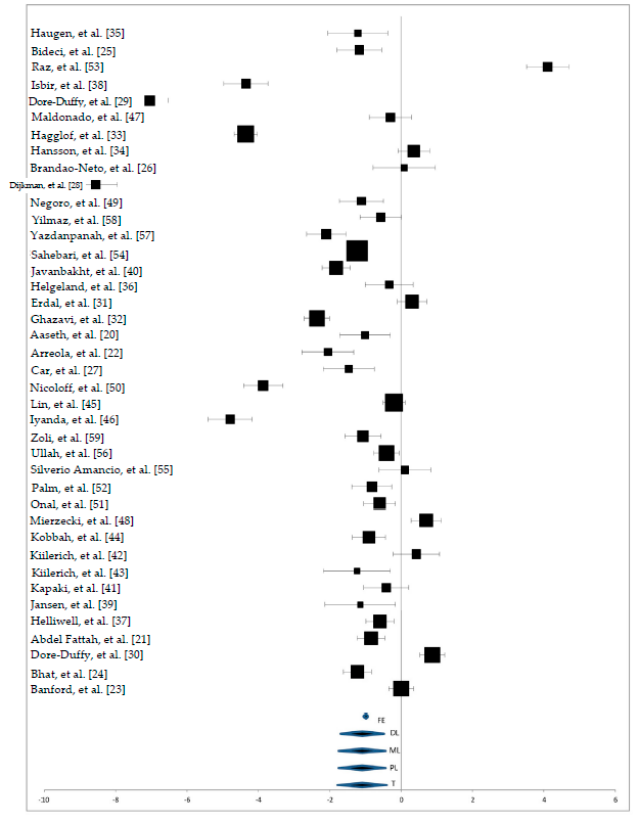
Figure 2. Forest plot of zinc status in serum samples. FE: Fixed Effects; DL: DerSimonial-Laird; ML: Maximum-Likelihood; PL: Profile—Likelihood; T: t -Test.